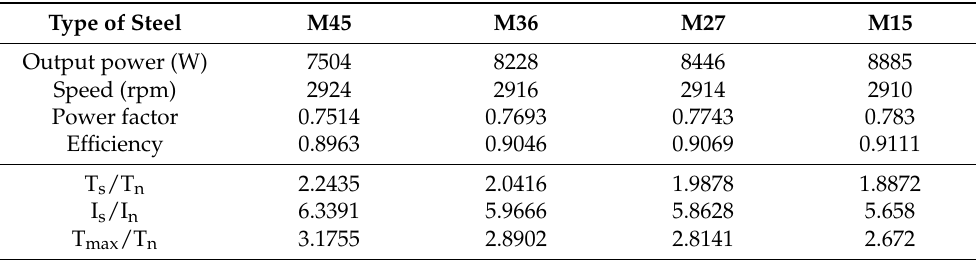
Table 9. Nominal, start, and maximum torque results on the 7.5 kW motor (equal heating criteria, variations of type of steel).